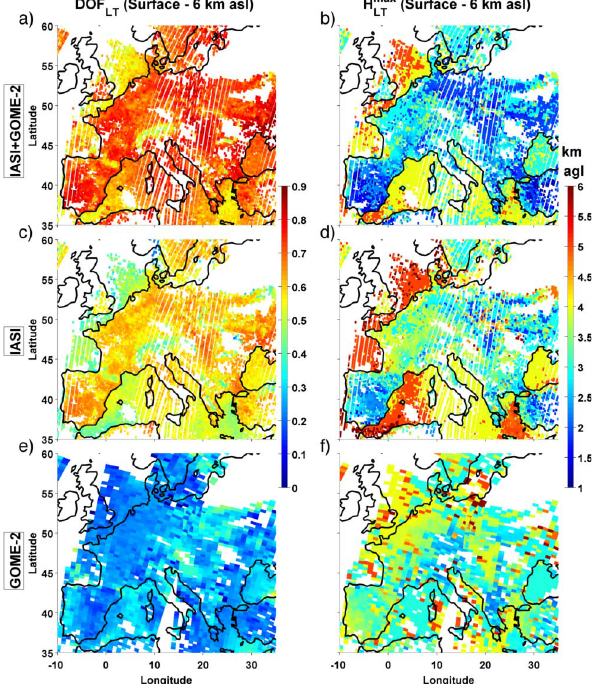
Fig. 6. Same as Fig. 4, but for the lowermost troposphere (LMT, from the surface up to 3km